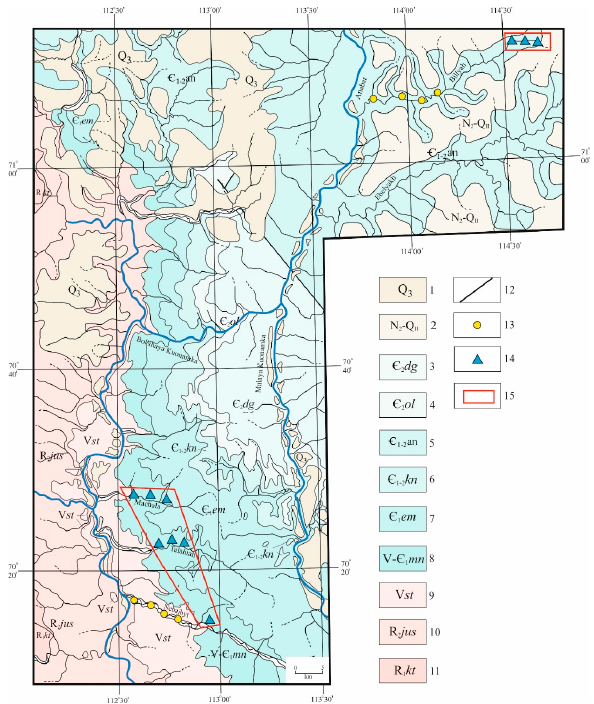
Figure 1. The scheme of the geological structure of the Anabar placer area [35,36]: 1—Quaternary alluvial sediments; 2—Neogene-Quaternary pebbles; 3–7—Cambrian sediments; 3—limestones of the Dzhakhtar formation; 4—clay and dolomitic limestones, marls of the Olenek formation; 5—dolomites of the Anabar formation; 6—clay, bituminous, organogenic-clastic limestones, combustible, siliceous, bituminous shales, siliceous and calcareous claystones, siltstones of the Kuonamskaya formation; 7—clay, dolomitic, algal, silty limestones and marls of the Emyaksin formation; 8—dolomitic lime- stones of the Manykai formation of the Vendian–Cambrian age; 9—dolomites, clay shales, gritstones and conglomerates of the Starorechenskaya formation of the Vendian; 10—dolomites, sandstones, siltstones, gritstones and conglomerates of the Yusmastakh formation of the Late Riphean; 11—sandy, clay dolomites, sandstones, gritstones, conglomerate-breccias of the Kotuikan formation of the Early Riphean; 12—faults; 13—places of collection of exploratory samples; 14—places of collection of hand specimen samples; 15—areas where hydrothermal-metasomatic formations were